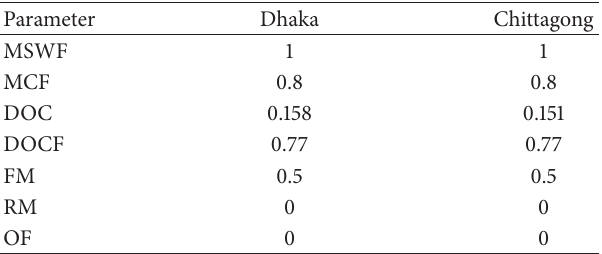
Table 6: Parameters adopted for IPCC default method in this study. Parameter